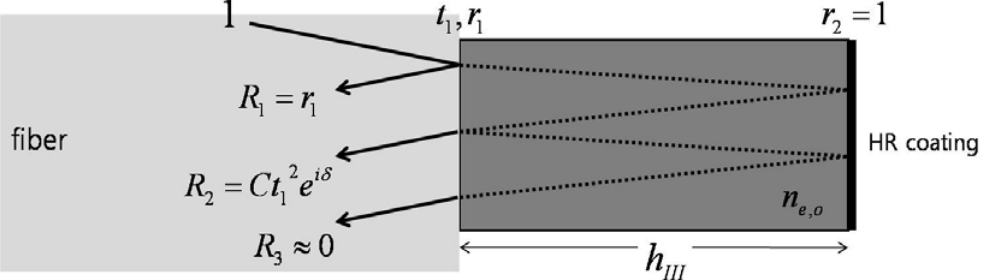
Figure 5. Reflected field components for type III probe (identical condition to Figure 2, >> h . Here, R ~ R >> R ≈ 0 except h III I 1 2 3